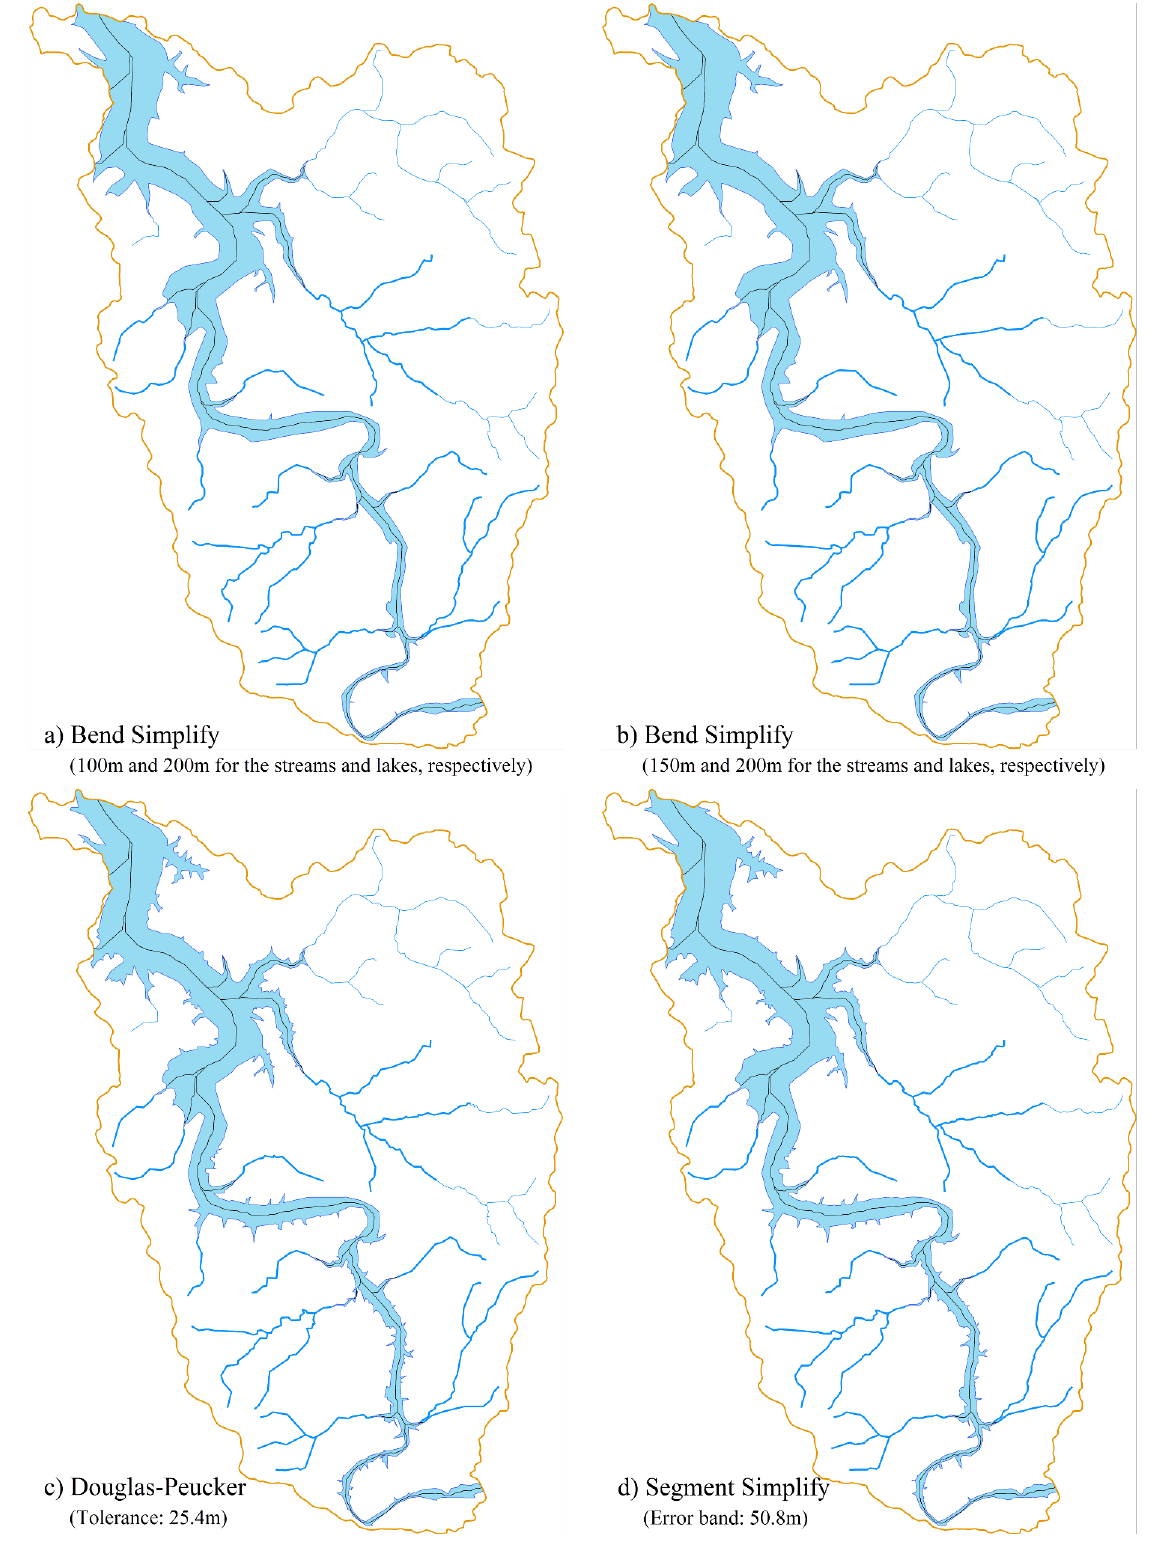
Figure 9. The outputs of the algorithms. ( a ) Bend Simplify (Tolerances: 100m and 200m for the streams and lakes, respectively). ( b ) Bend Simplify (Tolerances: 150m and 200m for the streams and lakes, respectively). ( c ) Douglas-Peucker (Tolerance: 25.4m). ( d ) Segment Simplify (Error band: